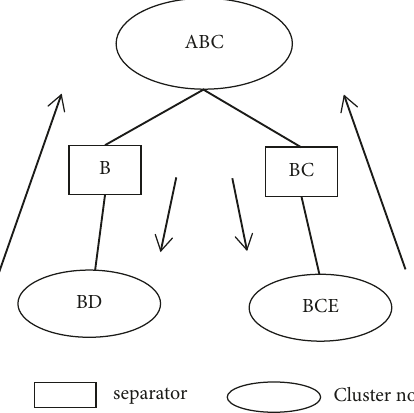
Figure 7: JT constructed by BN in Figure